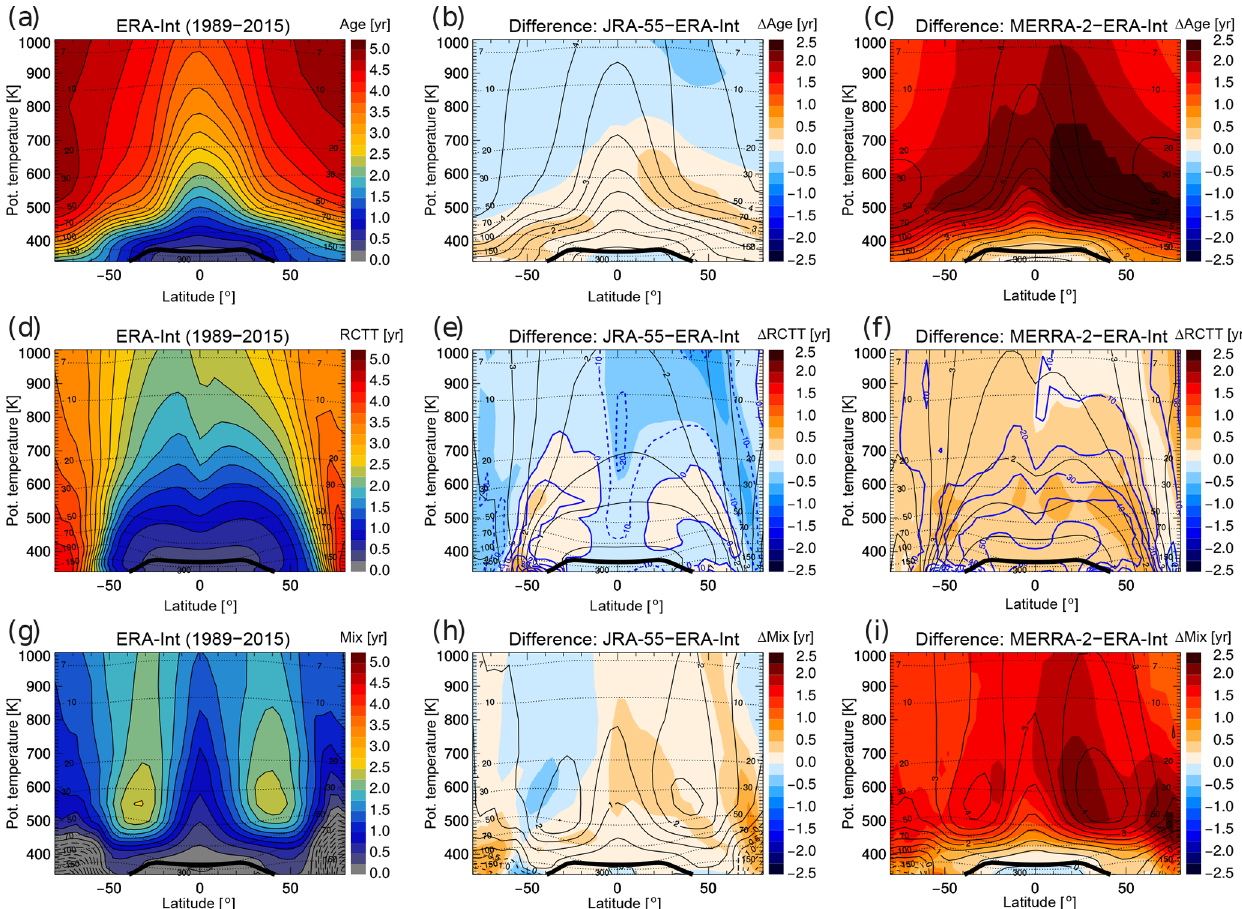
Figure 13. Mean age from ERA-Interim (a) , and differences to JRA-55 (b) and MERRA-2 (c) , for the 1989–2015 climatological mean. The same for residual circulation transit time RCTT is shown in (d) – (f) , and for ageing by mixing in (g–i) . The thin black solid contours show the climatology values for the respective reanalysis (e.g. ERA-Interim mean age in a , MERRA-2 mean age in c ), the thin black dashed lines show pressure levels, the thick black solid line show the (WMO) tropopause and the blue contours in (e) – (f) show relative differences for RCTTs in percent (solid for positive and dashed for negative